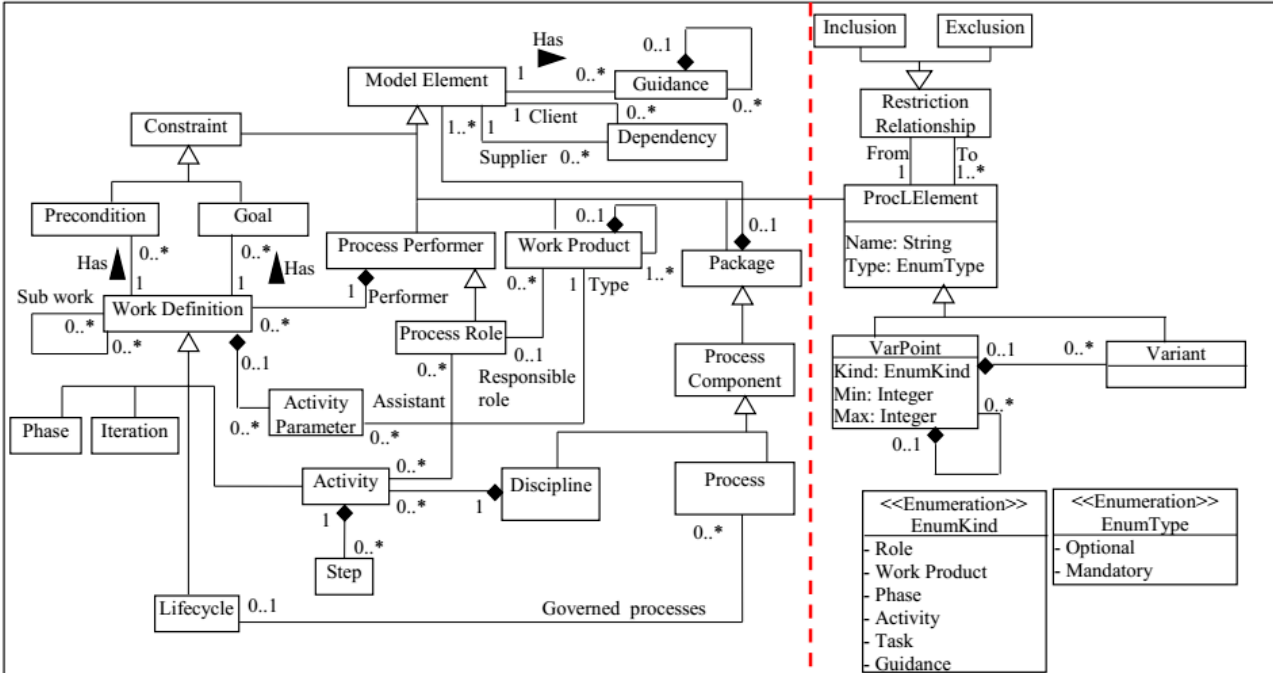
Figure 4. The variability metamodel used in the proposed SPrLE approach.